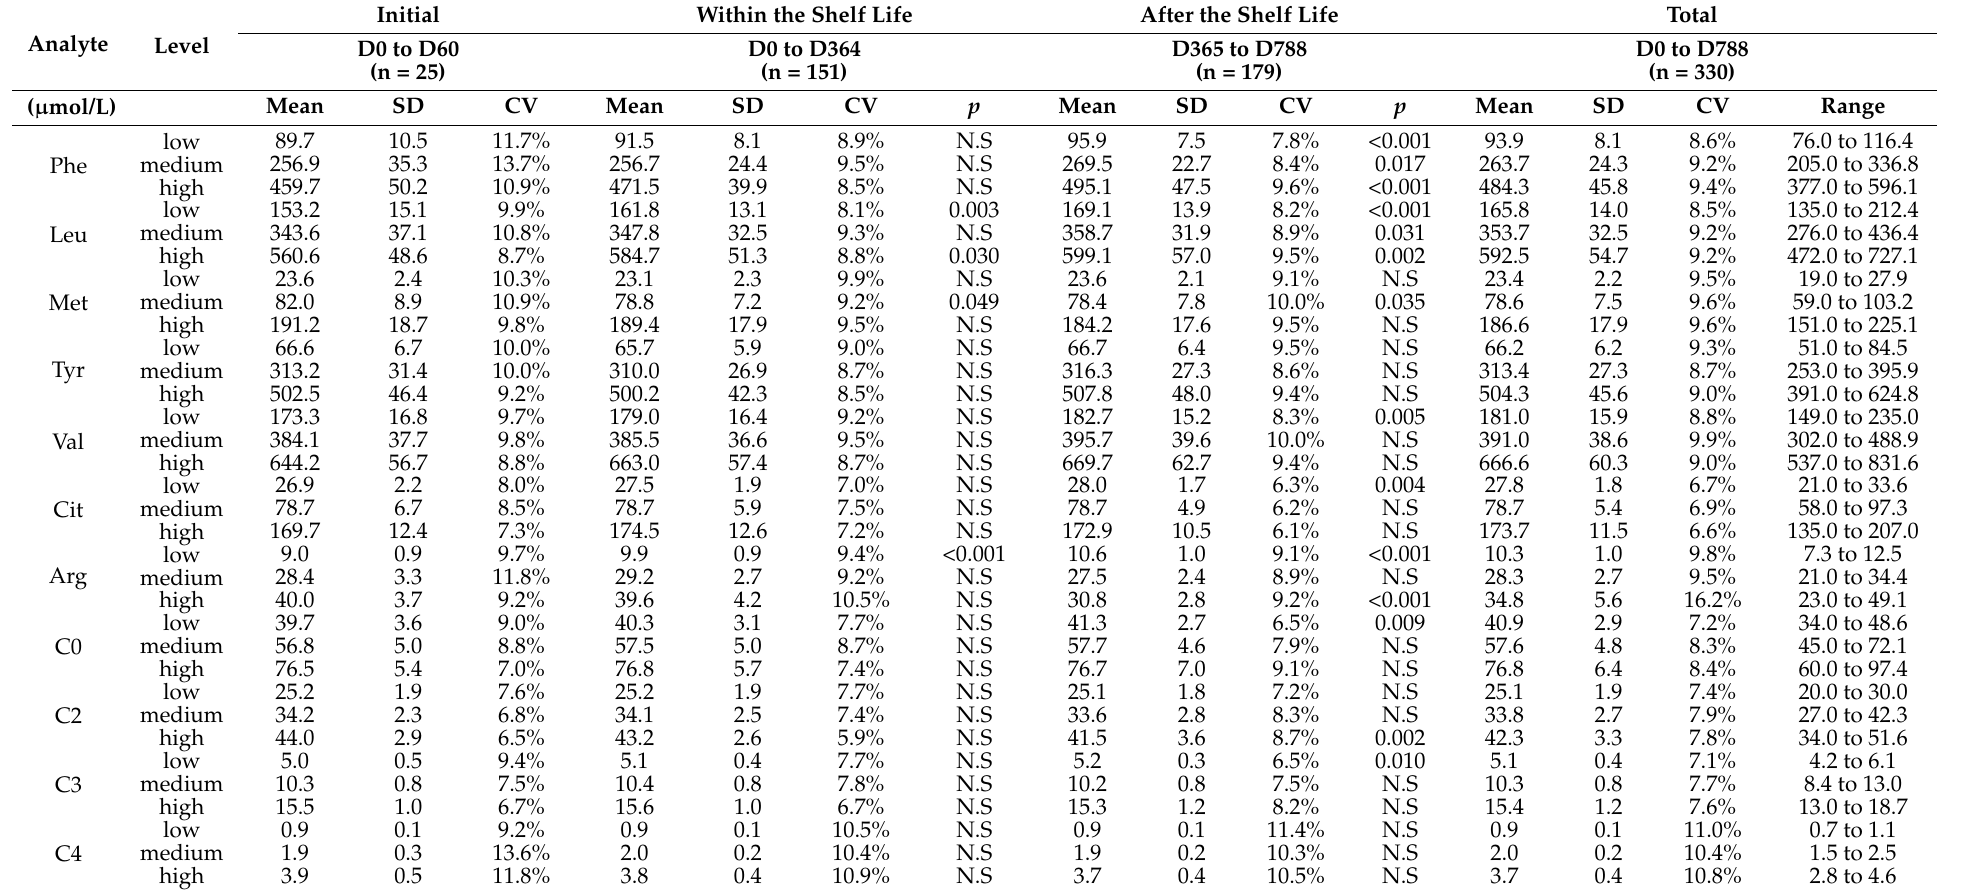
Table 1. The consecutive measured values of each analyte from NSQAP QC materials, according for the shelf